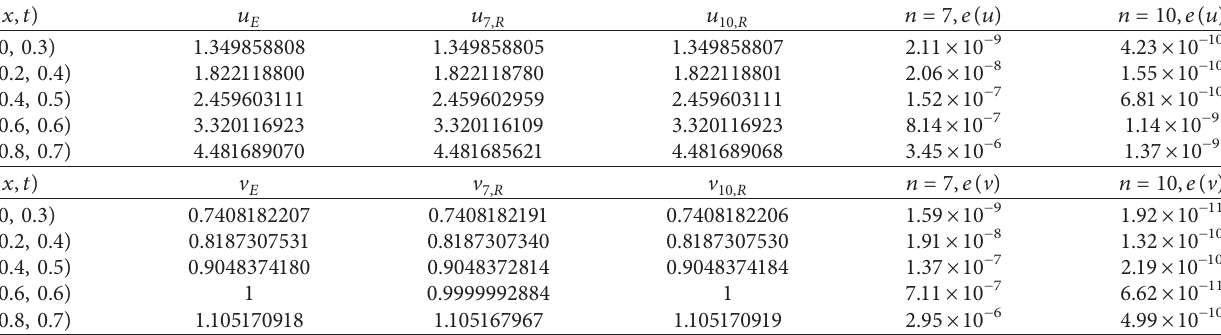
Table 8: Numerical result of Example 7.